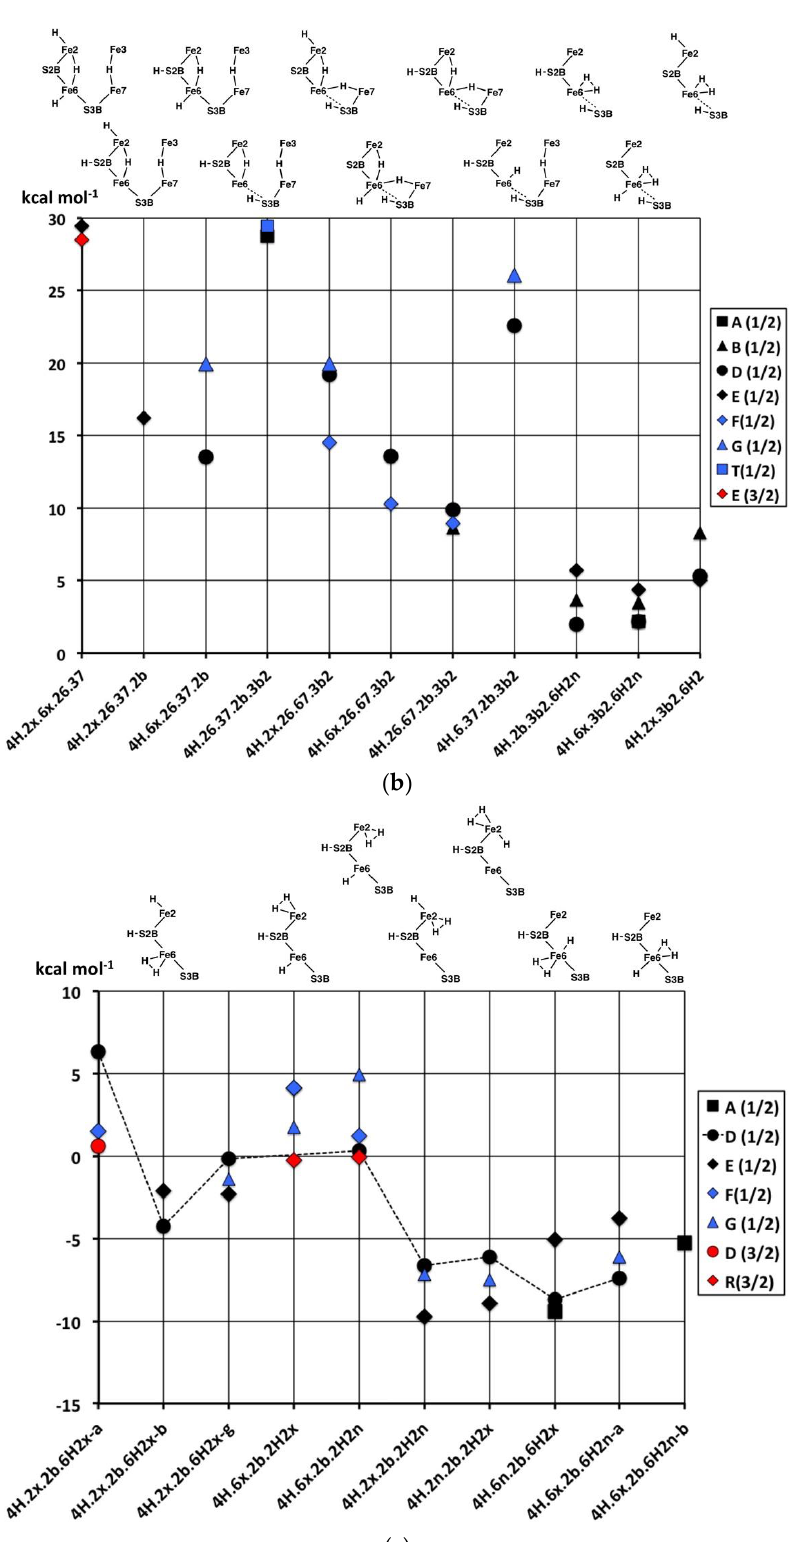
Figure 10. Relative potential energies (kcal mol −1 ) of the optimised structures with 4H or 2H + H 2 bonded to FeMo-co, in their best electronic/spin states. ( a ) Energies for the sequences of structures in Figure 9a. ( b ) Energies for the sequences of structures in Figure 9b,c. ( c ) Energies for the sequences of structures in Figure 9d. The three parts have the same energy reference. The tie lines are included only as a visual guide.